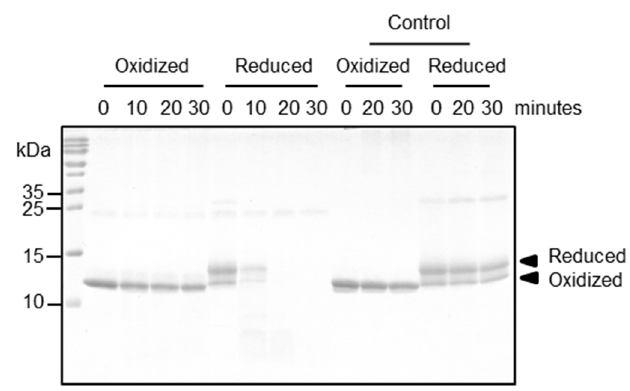
Figure 3. Proteolytic susceptibility of Bet v 2 towards cathepsin S. A time series digestion assay was performed at pH 5.5, 37 °C up to 30 min with cathepsin S (24 kDa) to Bet v 2 molar ratio of 1:20. Digestion profiles were visualized on SDS-PAGE under non-reducing condition and Coomassie Blue staining. As a control, Bet v 2 was monitored in the absence of a protease.